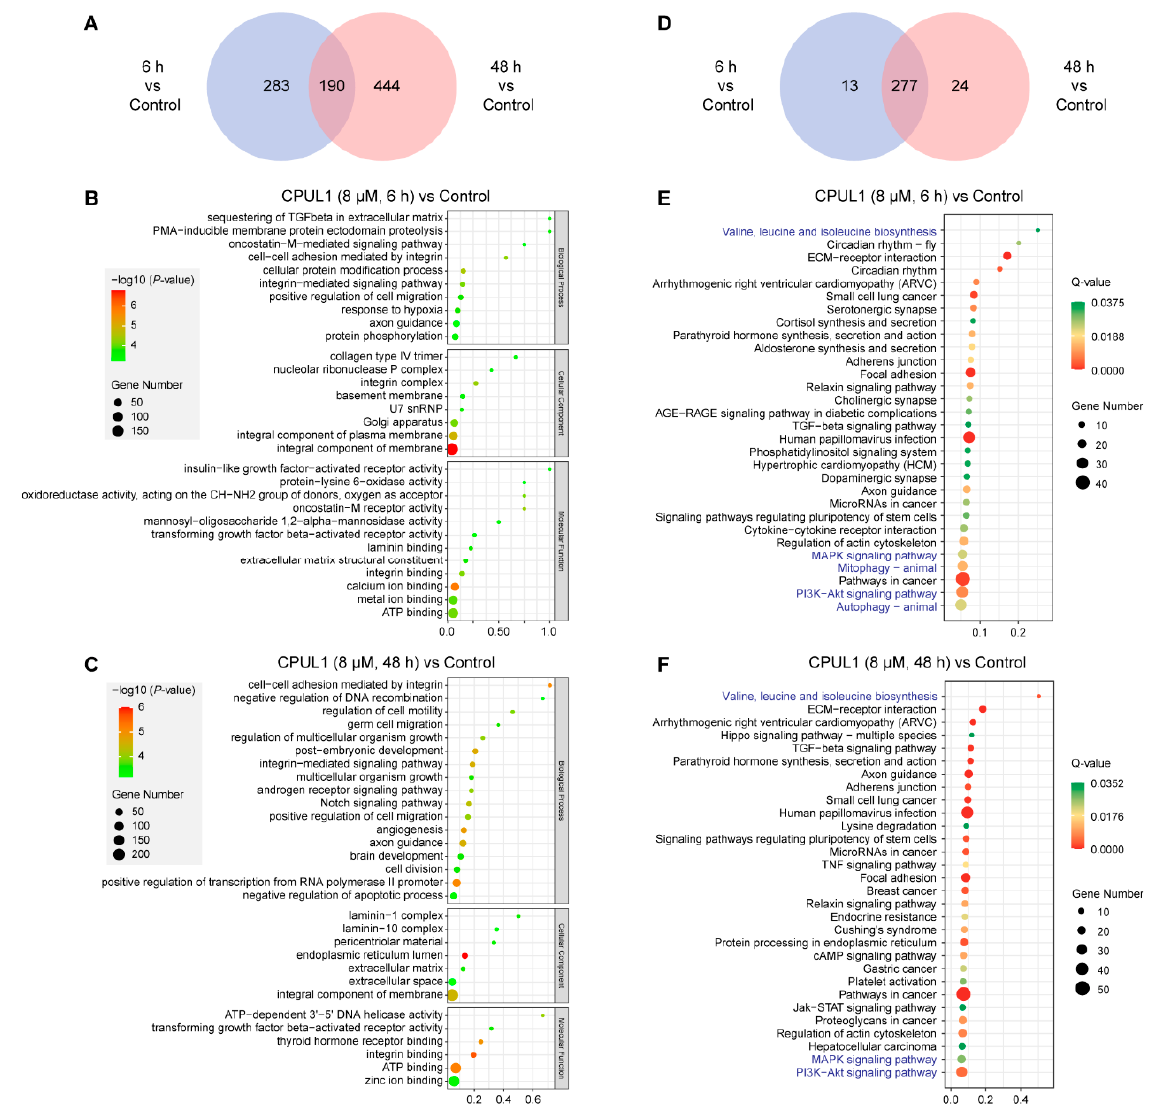
Figure 3. Top 30 enriched Gene Ontology (GO) terms and Kyoto Encyclopedia of Genes and Genomes (KEGG) pathway analysis on DEGs. ( A ) Venn diagram of GO terms. The numbers of GO terms were indicated. ( B ) GO terms of the cell’s DEGs under CPUL1 exposure of 6 h. ( C ) The GO terms of the DEGs of the cell under CPUL1 exposure for 48 h. The vertical and horizontal axes represent the GO terms and − log10 ( p -value) for each term, respectively. ( D ) Venn diagram of KEGG classifications. The number of KEGG classifications is indicated. ( E ) Bubble chart of the KEGG classifications of assembled DEGs under CPUL1 exposure for 6 h. ( F ) Bubble chart of the KEGG classifications of the assembled DEGs under CPUL1 exposure for 48 h. The vertical axis represents the KEGG terms. The size of the circles roughly represent the count of annotated genes. The color saturation from green to red indicates the Q -value.